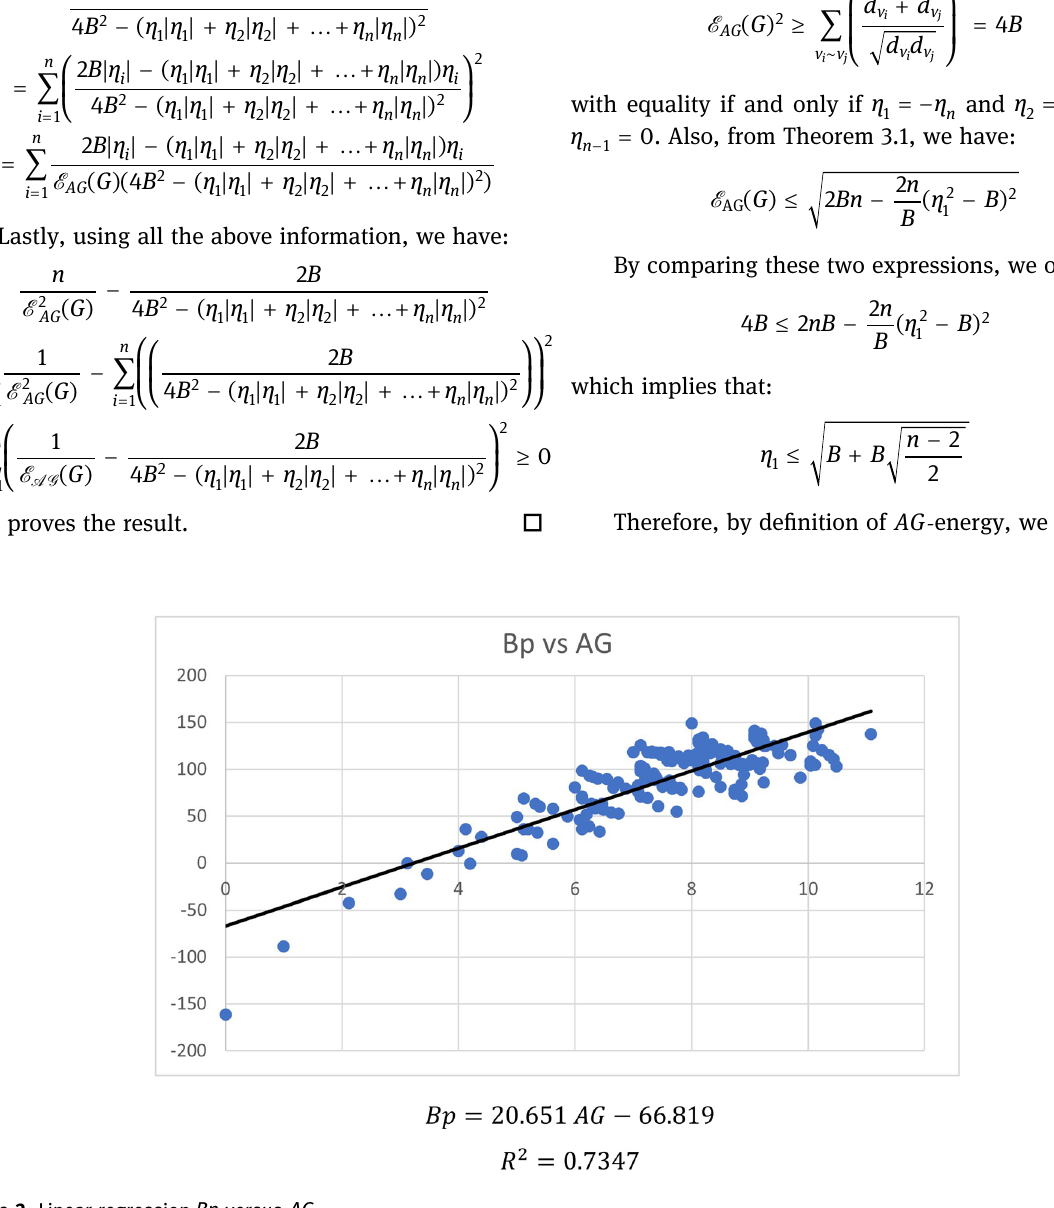
Figure 2: Linear regression Bp versus AG .